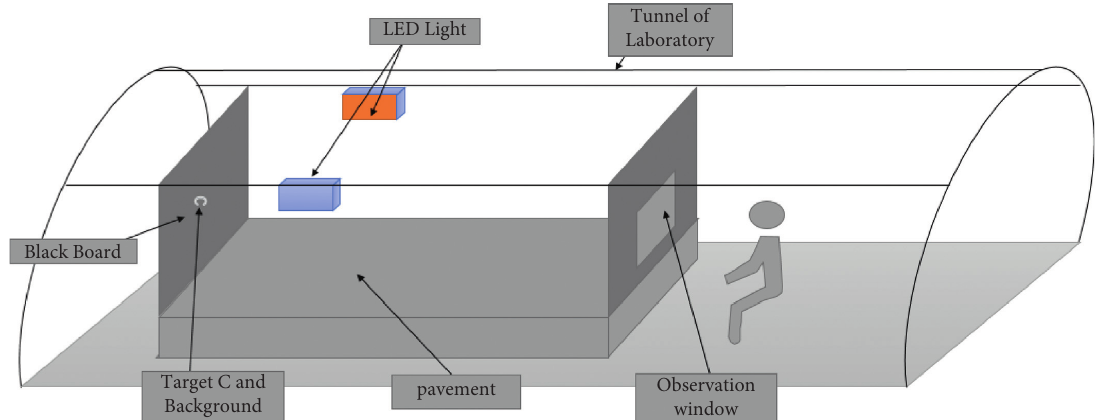
Figure 9: Real scene of the simulated tunnel in the laboratory.